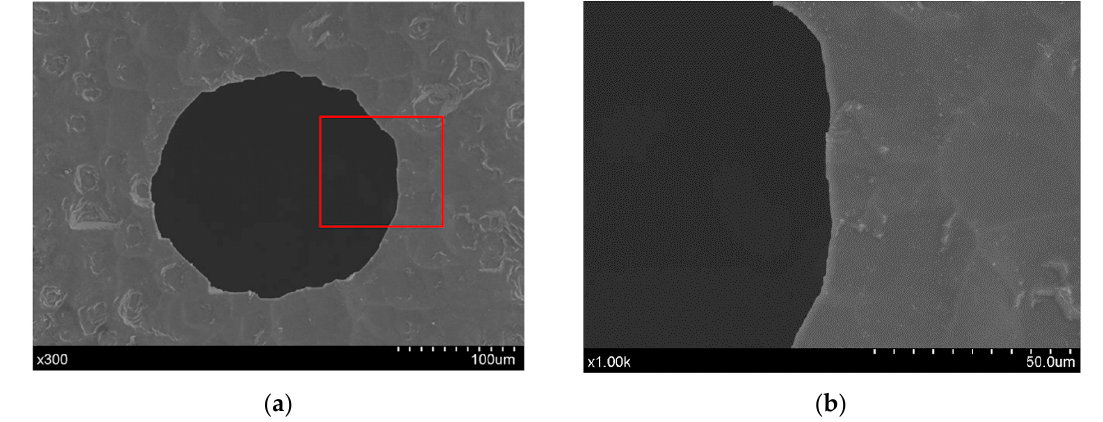
Figure 12. Exit details of the chemical-assisted micro-trepanning results, where ( a ) is an overall view, while ( b ) shows the details within the red square. The processing parameters include: P = 25.5 W, f = 0.8 MHz, v = 300 mm/s, n = 15, m = 120, and a NaOH solution with a concentration of one mol/L was used in chemical-assisted laser processing.